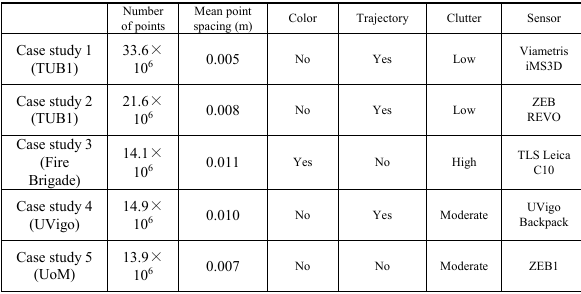
Table 1. Specifications of the point clouds of the ISPRS benchmark